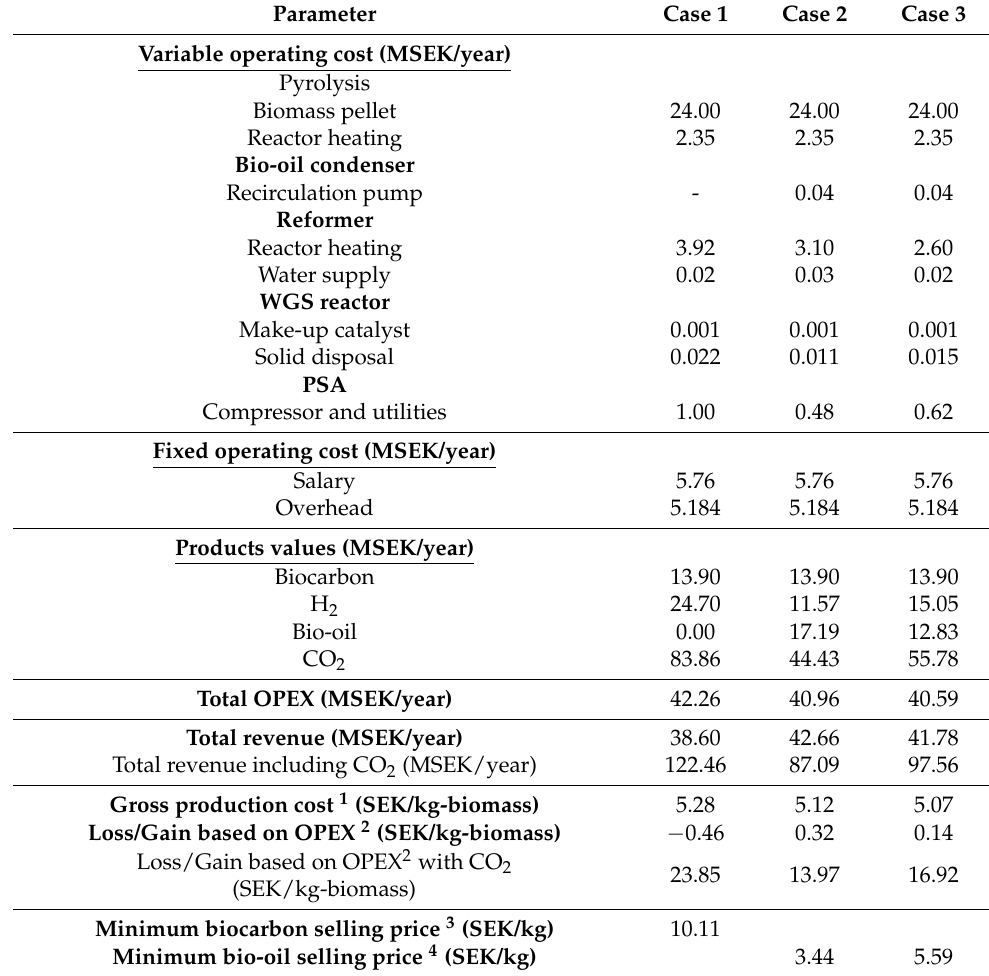
Table 11. Annual operation costs for the co-production process of biocarbon, hydrogen, and